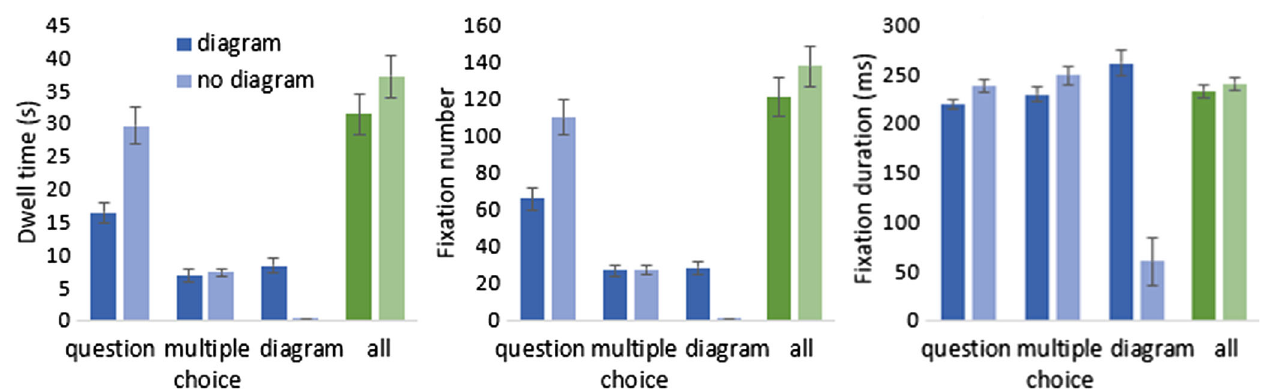
FIG. 2. Dwell time, number of fixations, and average fixation duration for three AOIs ( question , multiple choice, and diagram ) and all three summed AOIs (shown in green) on question Q3. The error bars represent 1